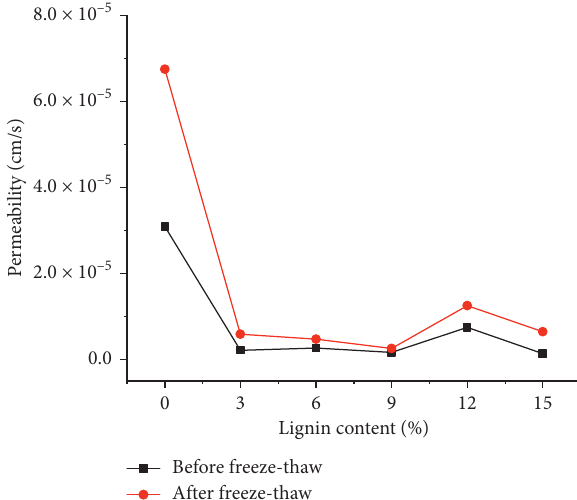
Figure 10: Effect of freeze-thaw and lignin content on the permeability.